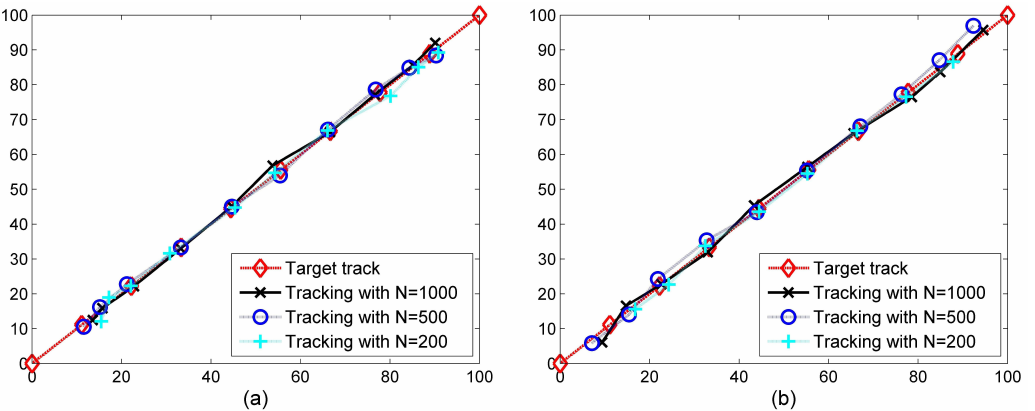
Figure 8. Accuracy of Red-S in tracking a moving target through a network in a 100 m × 100 m region. N indicates the number of network nodes. P 0 = 1000 and local false alarm rate p fa have been considered in the simulations. ( a ) Without edge effect correction. ( b ) With edge effect